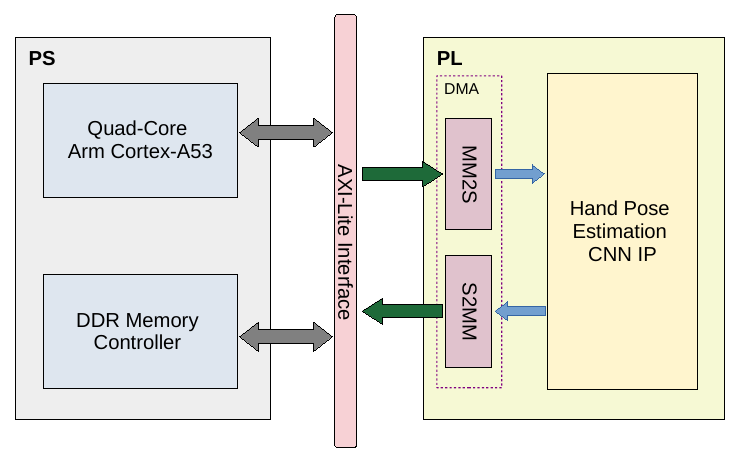
Figure 8. Hardware system integration; AXI-Lite interface provides the interconnection between the PS and the PL. DMA module is integrated in the PL. This module is responsible for converting the memory mapped input to AXI stream CNN input, as well as converting the AXI stream CNN output to a memory mapped